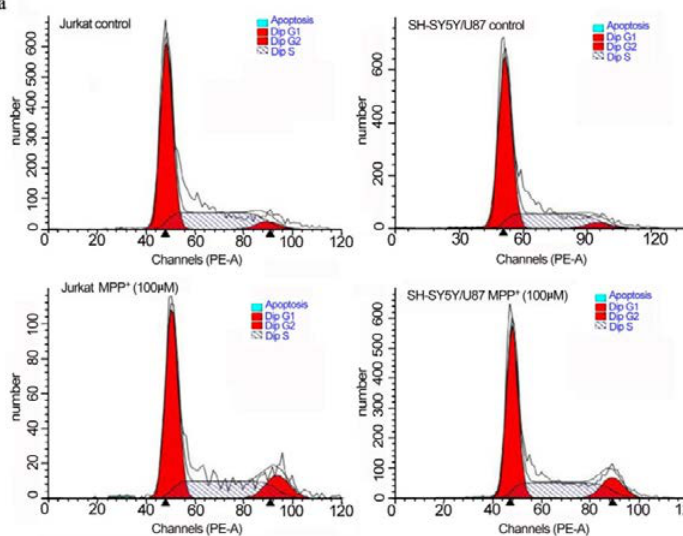
Figure 3. One hundred micro mole per liter MPP + -treated co-culture medium of SH-SY5Y and U87 cells induced Jurkat cell G2/M cell-cycle checkpoint. Jurkat cells treated with or without MPP + as background control, Jurkat cells incubated with the conditioned media of co-culture system treating without MPP + as control. ( a ) Cell cycle of G2/M phase of Jurkat cells was increased after 100 µM MPP + application compared to control medium without MPP + . ▲ means the position of Dip G1 and Dip G2; Dip G1 is the left red peak and Dip G2 is the right red peak; ( b ) Statistical analysis for the effect of conditioned media after 100 µM MPP + application on inducing cell cycle arrested. ** p < 0.01, compared with Jurkat cells in co-culture medium without MPP + applied; ( c ) Western blot assay for the G2/M cell-cycle checkpoint-related proteins. Phosphorylation of CDC2 was increased while Cyclin B1 decreased in protein level of Jurkat cells in MPP + -treated co-culture medium; ( d ) Quantification of intensities of CyclinB1/β-actin by Bio-Rad imaging-lad 4.0 software (Bio-Rad, Richmond, CA, USA). * p < 0.05 compared with Jurkat cells in co-culture medium without MPP + applied; ( e ) Quantification of intensities of p-CDC2/CDC2 by Bio-Rad imaging-lad 4.0 software. * p < 0.05 compared with Jurkat cells in co-culture medium without MPP +